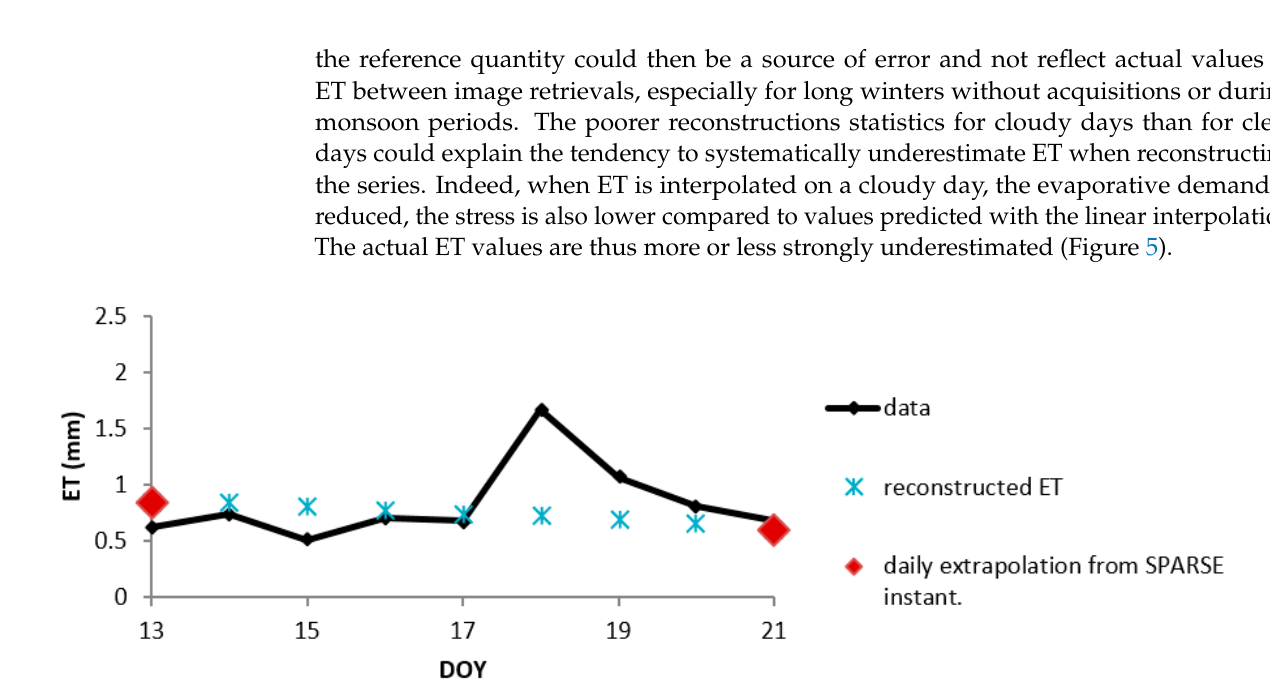
Figure 5. Reconstructed ET over a cloudy period for an 8 days revisit frequency in Kairouan 2012, with a cloudy sky without precipitations on Day 18.